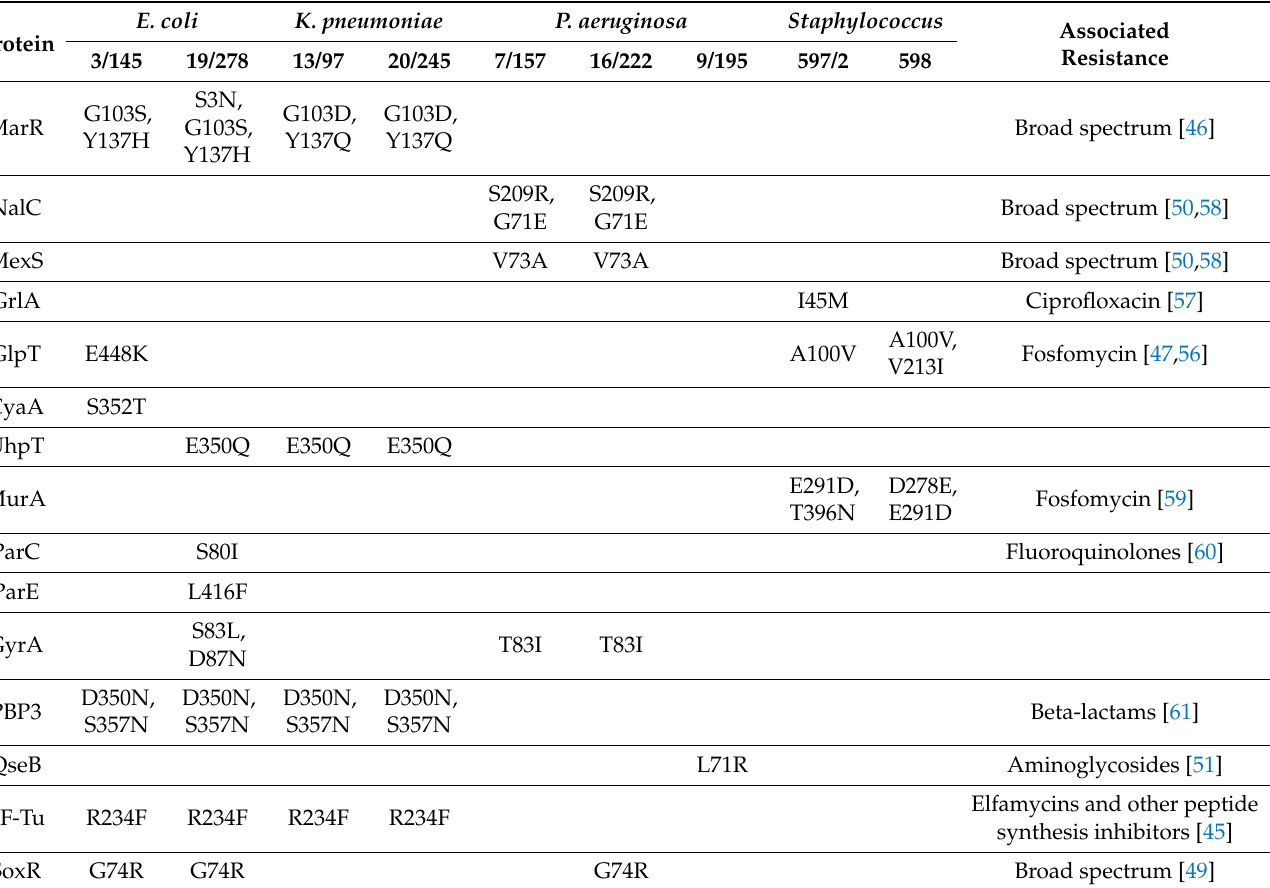
Table 2. Mutations associated with antibiotic resistance identified in CARD-RGI